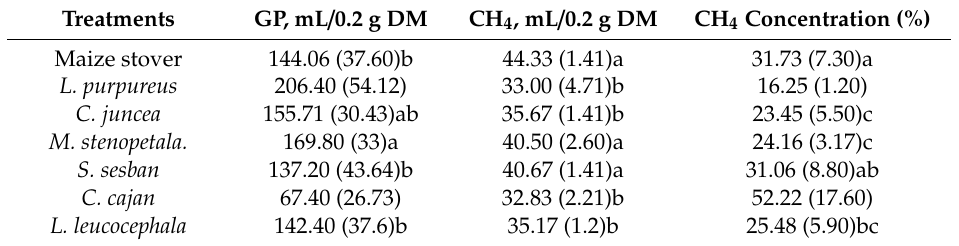
Table 4. Means of total gas production (GP), CH 4 production and concentration (as a proportion (%) of total